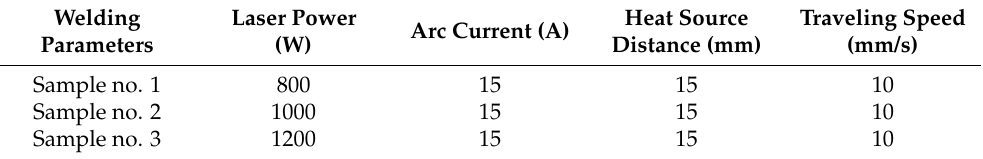
Table 2. Welding parameters.